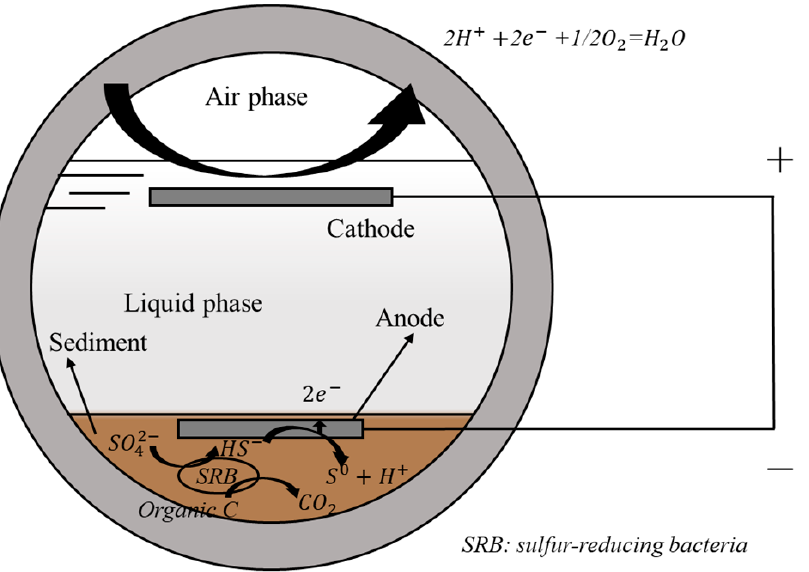
Figure 4. Schematic of the principle of sulfide reduction by microbial electrolysis cell (MFC) in drainage pipelines.